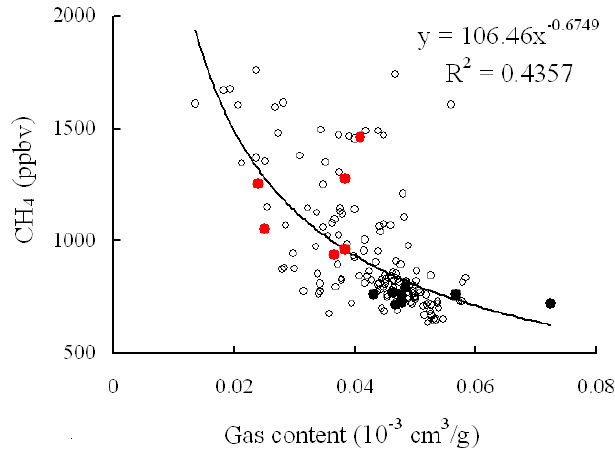
Fig. 2. Distribution of CH 4 mixing ratios against gas content of the same samples in ER ice cores, with an exponential fit. Samples with CH 4 mixing ratios over 1800ppbv are excluded. The solid circles stand for the filtered 15 samples that are used for the discussion, with the red solid circles for the industrial records and the black solid circles for the preindustrial